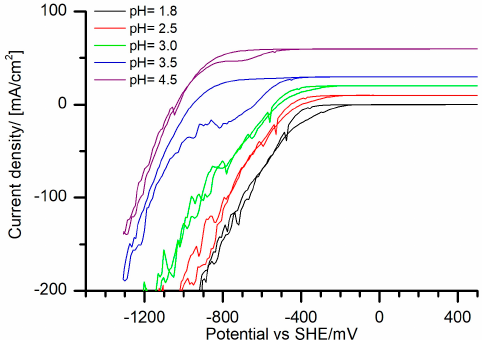
Figure 2. Cyclic voltammograms (CVs) of the supporting electrolyte recorded at different pH values of the electrolyte (offset 10 mA/cm 2 ) with the scan rate of 50 mV/s.